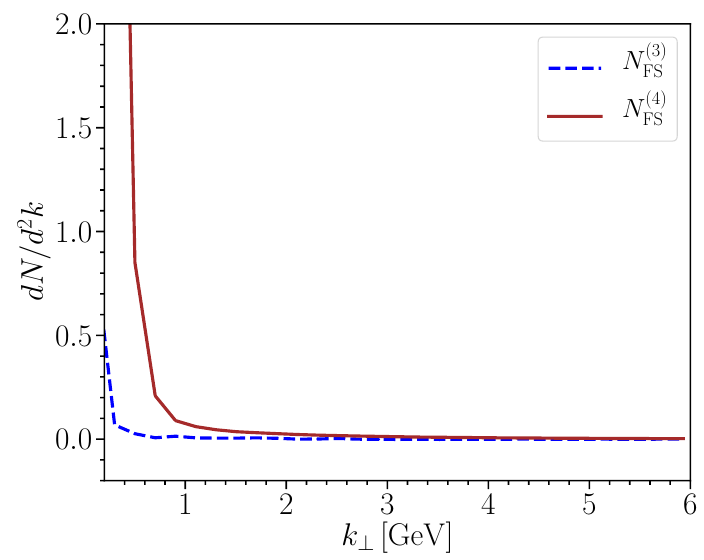
Figure 9. Final state interactions from three-Wilson-line terms and four-Wilson-line terms. The target saturation scale is chosen to be Q s,T = 2 GeV